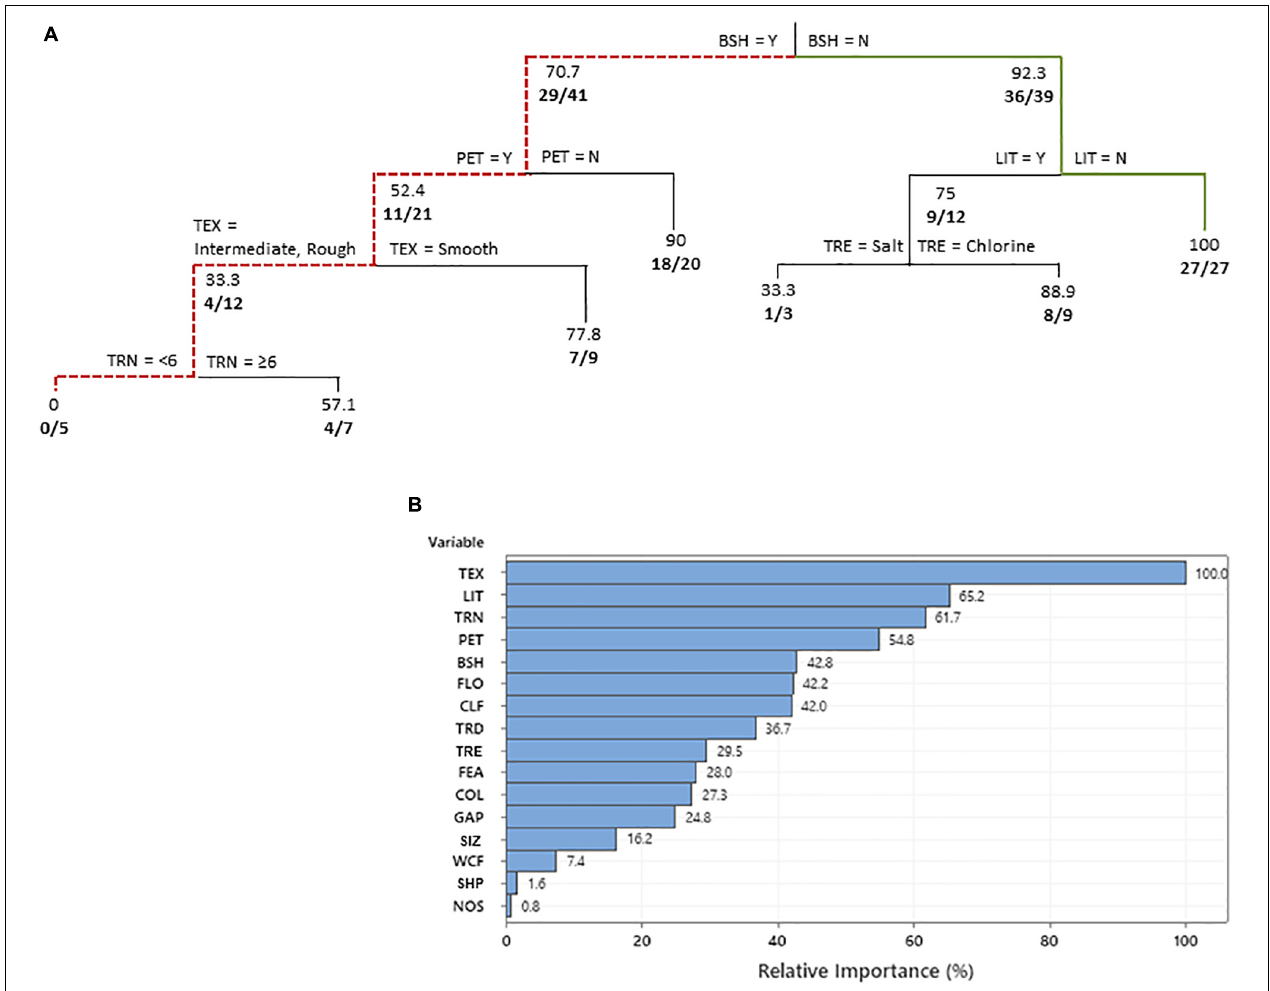
FIGURE 3 | Classification tree (A) predicting the swimming pool characteristics that influenced bat activity observed over the pools of residents in a suburban neighborhood in Fort Worth, TX, United States. The variable predictors that create a split are labeled at each branch split. Below each node values represent the percentage of responses in which bats were observed and number of positive responses along with the total number of responses considered are given in bold. A bold solid green line shows the combination of independent variables that led to the most observations and a red dotted line shows the variables resulting in the least observations. Relative variable importance chart (B) with relative importance defined as % improvement with respect to the top predictor. TEX, pool interior texture; LIT, pool lighting; TRN, number of trees visible from the pool; PET, pets in backyard between 7 pm and 6 am; BSH, bushes/shrubs and structures ( < 2 m) close to or bordering pool; FLO, are pool floaties left overnight; CLF, how often is pool cleaned; TRD, distance (m) of trees from pool; TRE, pool treatment; FEA, connected hot tub/fountain/waterfall feature present; COL, color of pool interior; GAP, distance of gap between tree canopies; SIZ, surface area of swimming pool m 2 ; WCF, walled edge/cliff/fence present; SHP, pool shape; and NOS, high frequency noises generated between 7 pm and 6